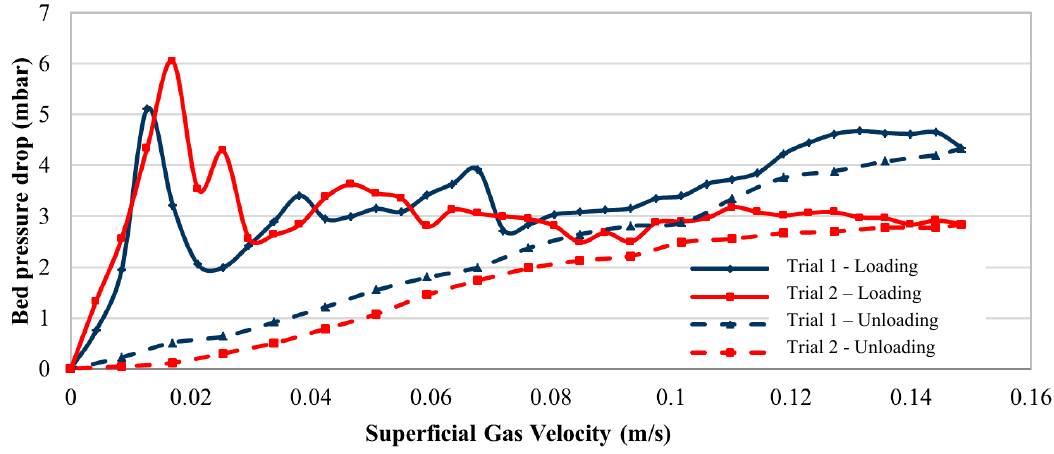
Figure 9. Two independent fluidization tests—loading (—) and unloading ( ‒ ‒ ) of mixed material—(30% of ultra-fine + 70% of fine particles).